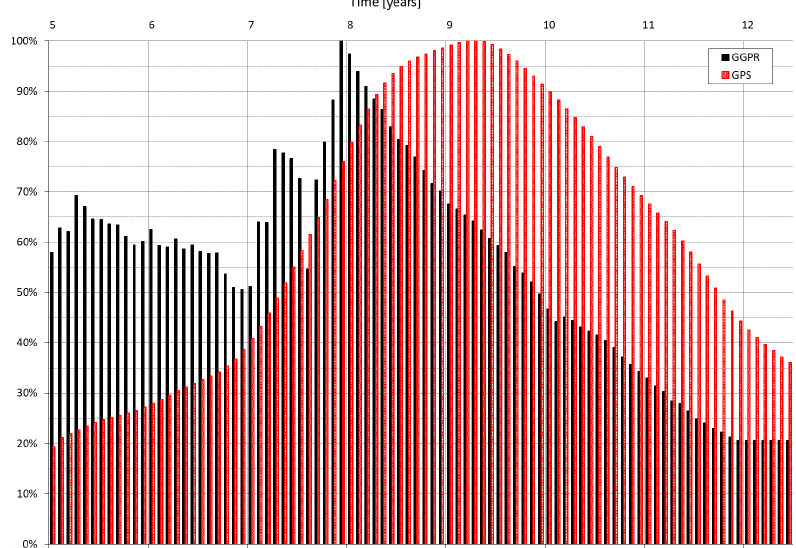
Figure 1. Monthly data for platform B: gas production rate (GGPR) versus GPS rate filtered from seasonal component.